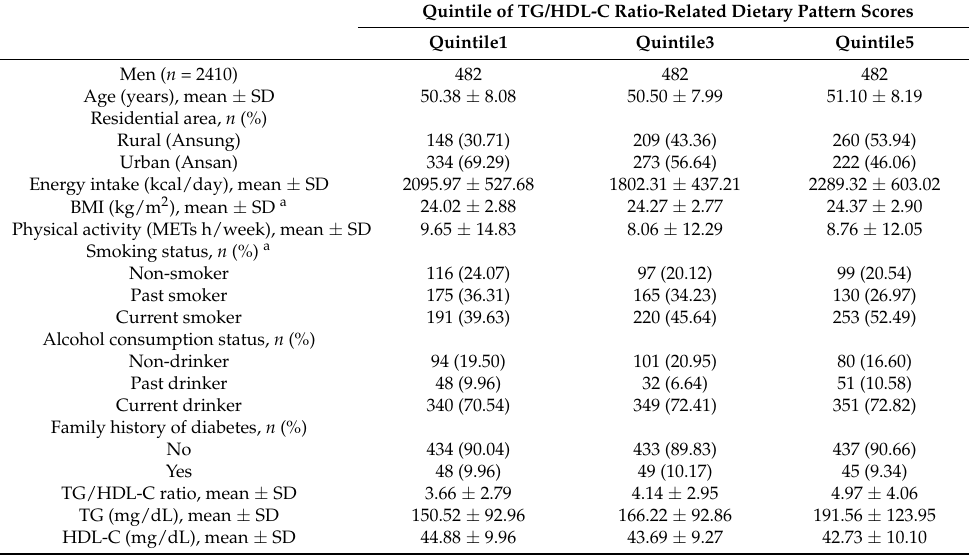
Table 2. Baseline characteristics of the study participants according to the quintiles for TG/HDL-C ratio-related dietary pattern